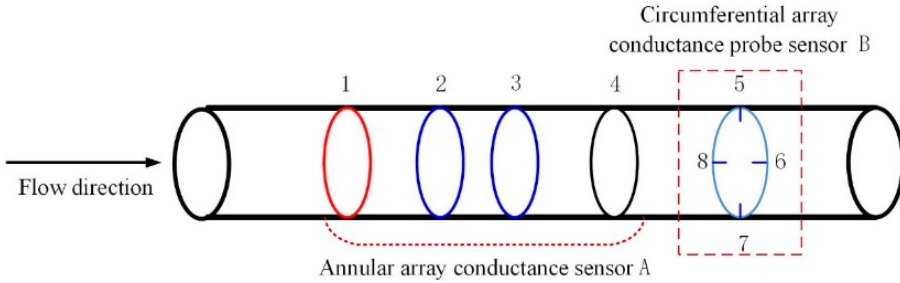
Figure 1. Schematic diagram of water holdup sensors of horizontal well.